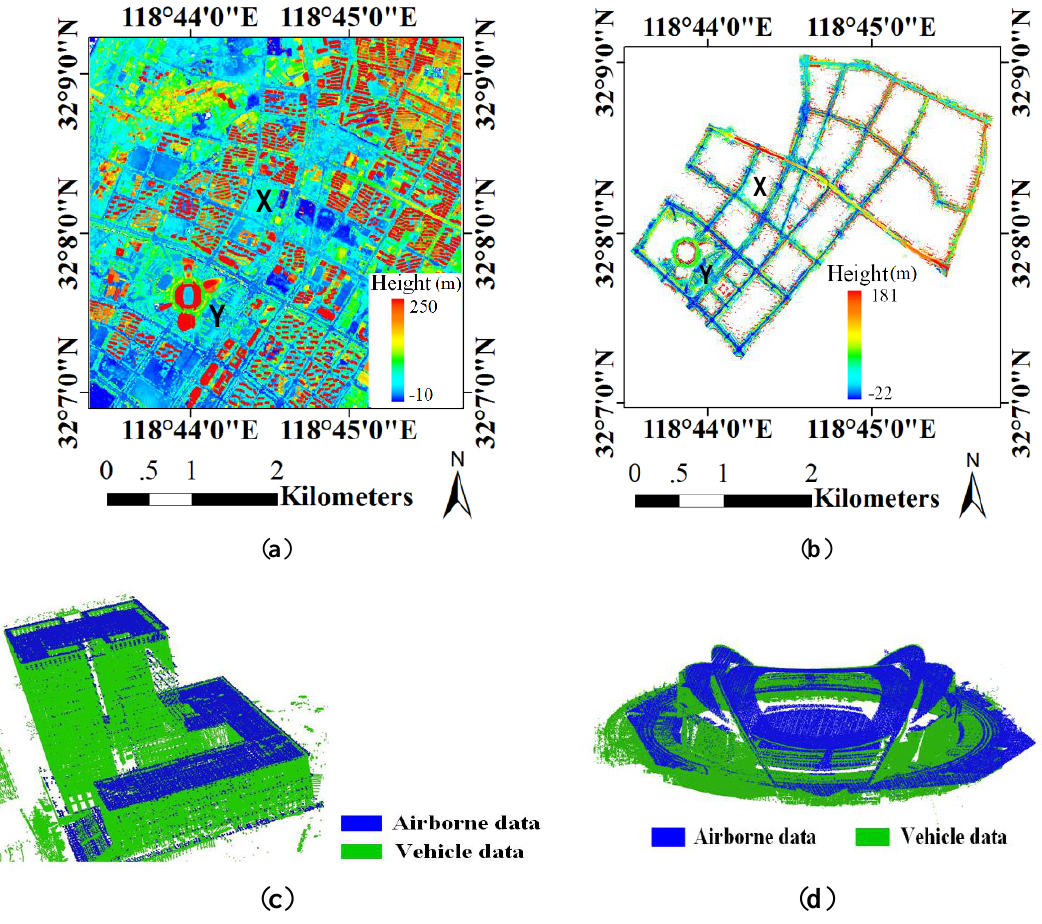
Figure 1. An example of “point city” with registered airborne and vehicle LiDAR points. ( a ) Airborne LiDAR points; ( b ) Vehicle LiDAR points; ( c ) Building X in “point city” (blue points: airborne data, green points: vehicle data); ( d ) Building Y in “point city” (blue points: airborne data, green points: vehicle